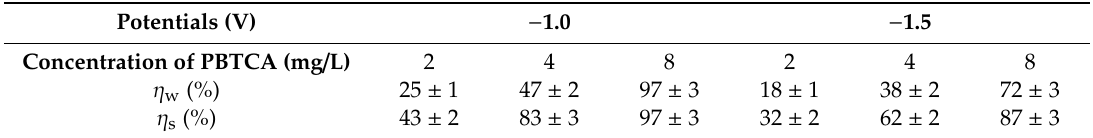
Table 2. The cathode surface-scale-inhibition e ffi ciency ( η w ) and the solution-scale-inhibition e ffi ciency near the cathode surface ( η s ) of PBTCA under di ff erent polarization potentials. Potentials (V) − 1.0 − 1.5 Concentration of PBTCA (mg / L)